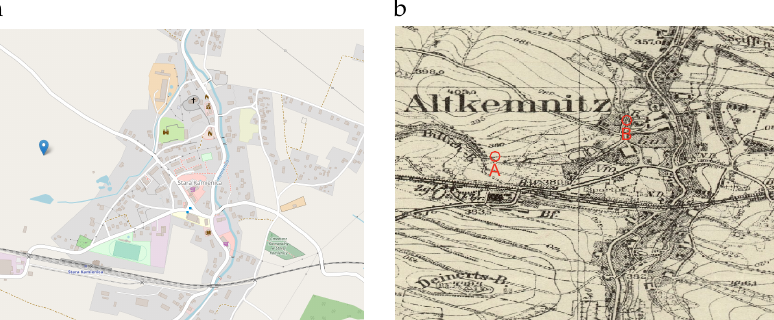
Figure 8. Map of Stara Kamienica: ( a ) Retrieved from the OpenStreet Map service (in EPSG:4326). ( b ) Retrieved from the Mapster website and georectified (in EPSG:2180). The point obtained from Wikipedia is shown with a marker in ( a ) and is labeled with A in ( b ). The point labeled with B in ( b ) represents the correct location as delivered by Pa´nstwowy Rejestr Nazw Geograficznych (PRNG: “National Register of Geographical